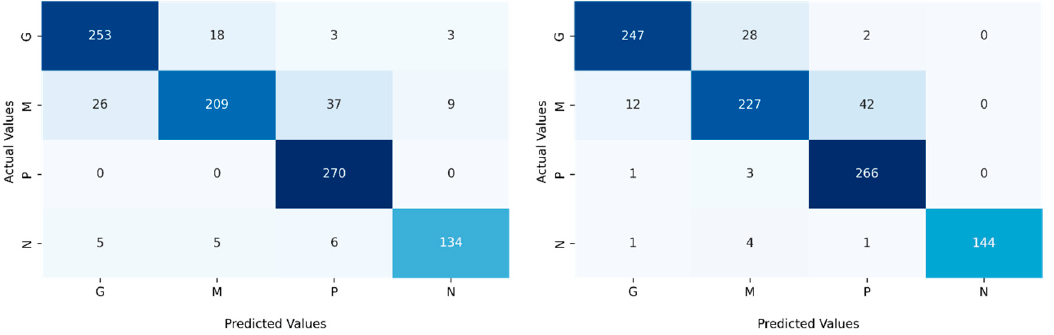
Figure A5. Confusion Matrices for simple Convolutional Network ( left ) and Xception-based net- work ( right ).